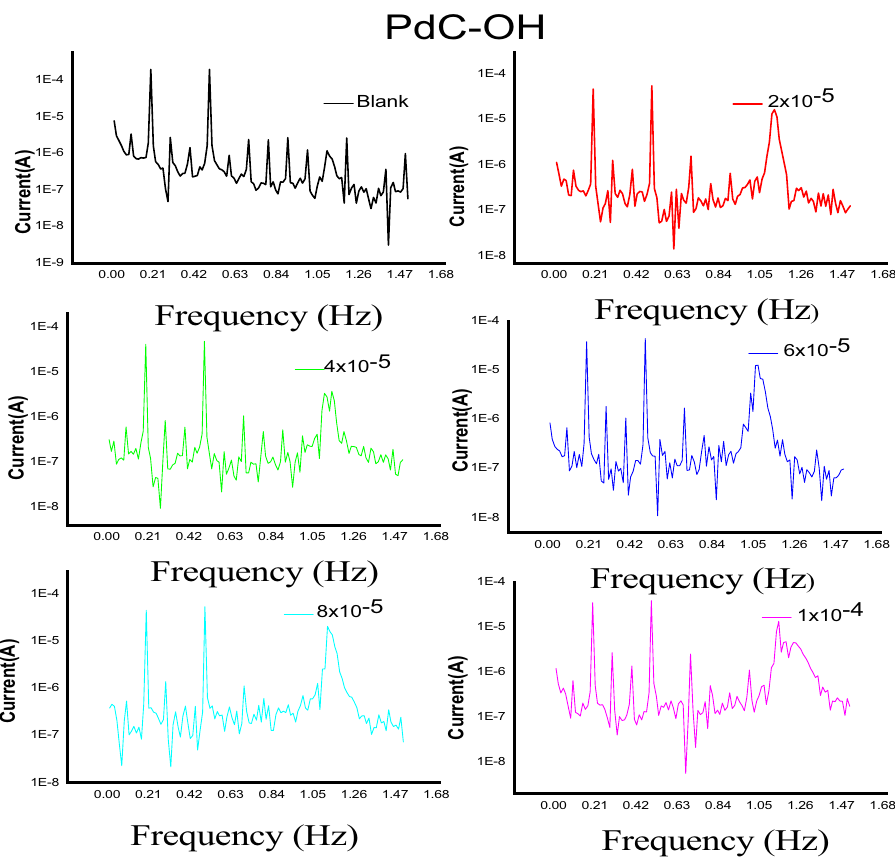
Figure 10. EFM spectra of carbon steel in 1 M HCl without and with various concentrations of PdC-OH at 25 °C.